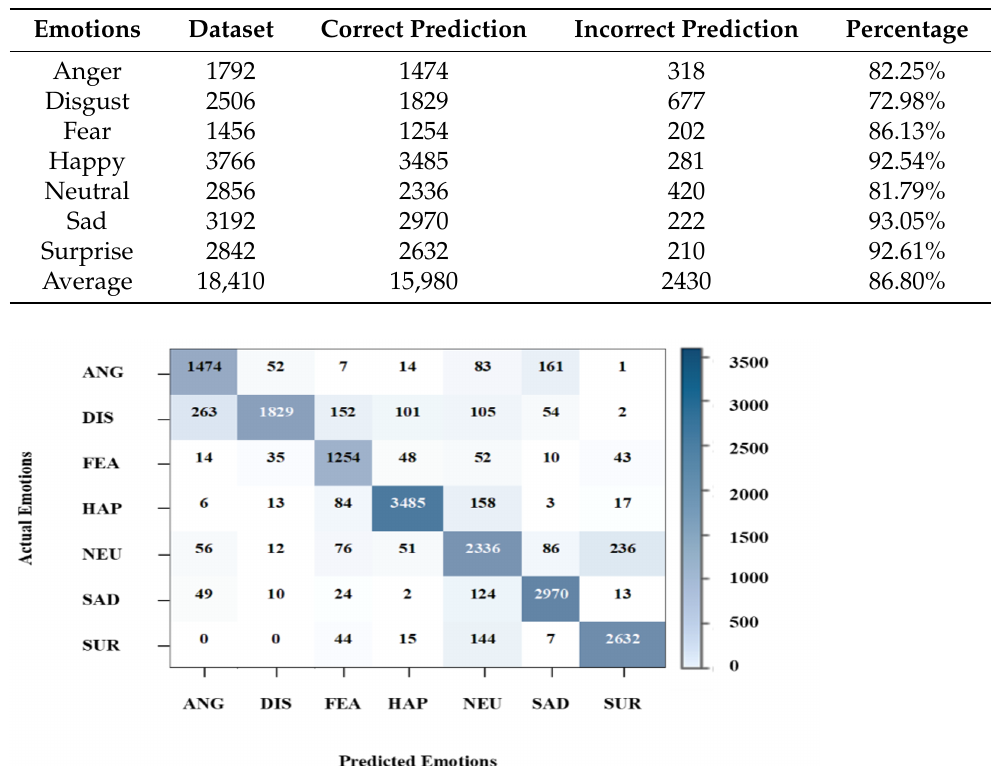
Figure 4. Confusion matrix of Test Model 2 after 10 epochs. Table 10. Test result with prediction detail of the proposed model after 10 epochs.